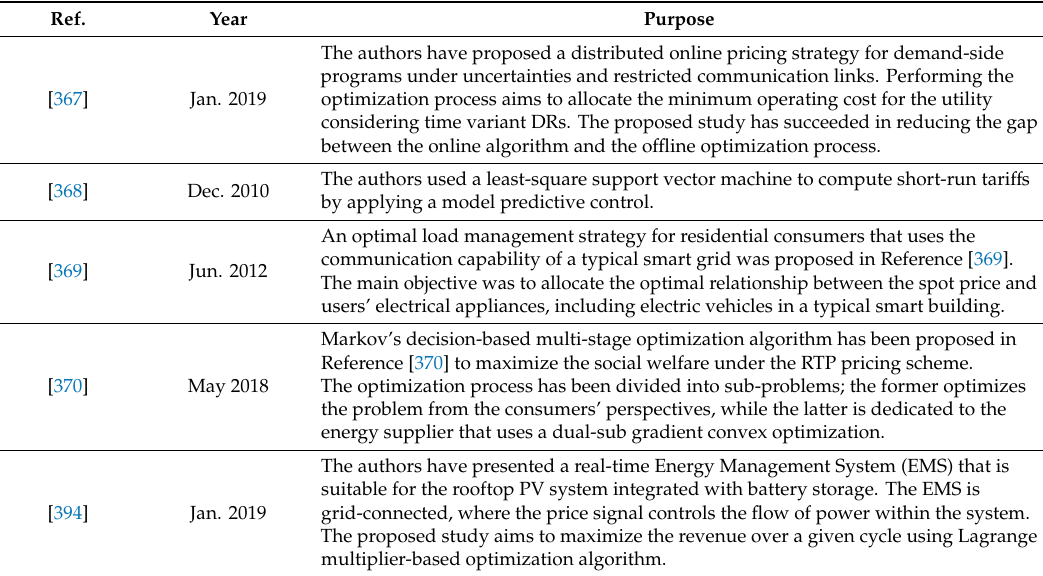
Table 12. Recent development in real-time pricing (RTP) pricing